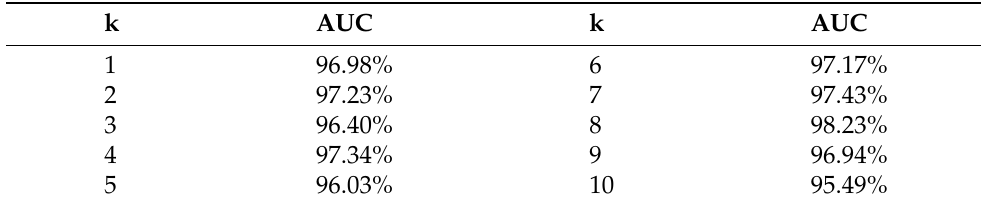
Table 4. The 10 k-fold cross validation (10-layer DNN).